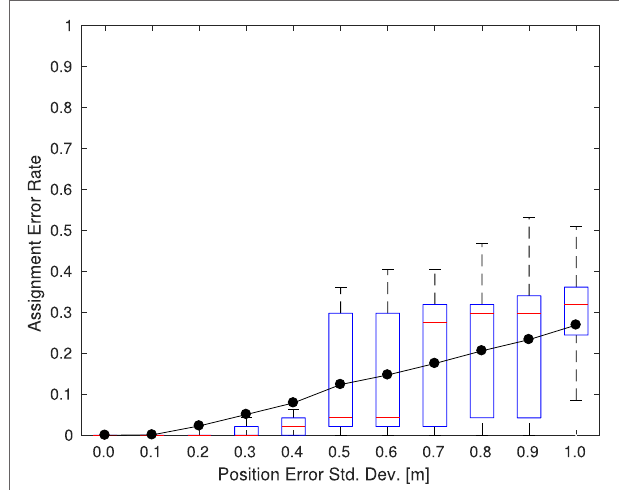
FIGURE 9 | The misassignment rate in the crossing scenario.